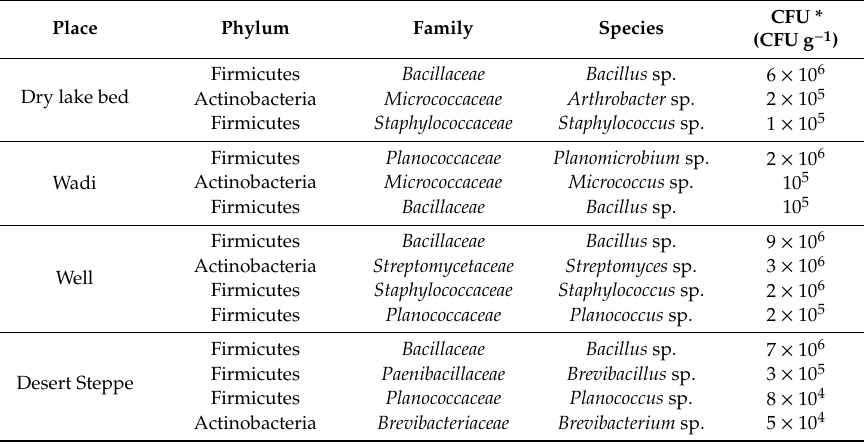
Table 2. Detection of Microbes in Gobi Desert.